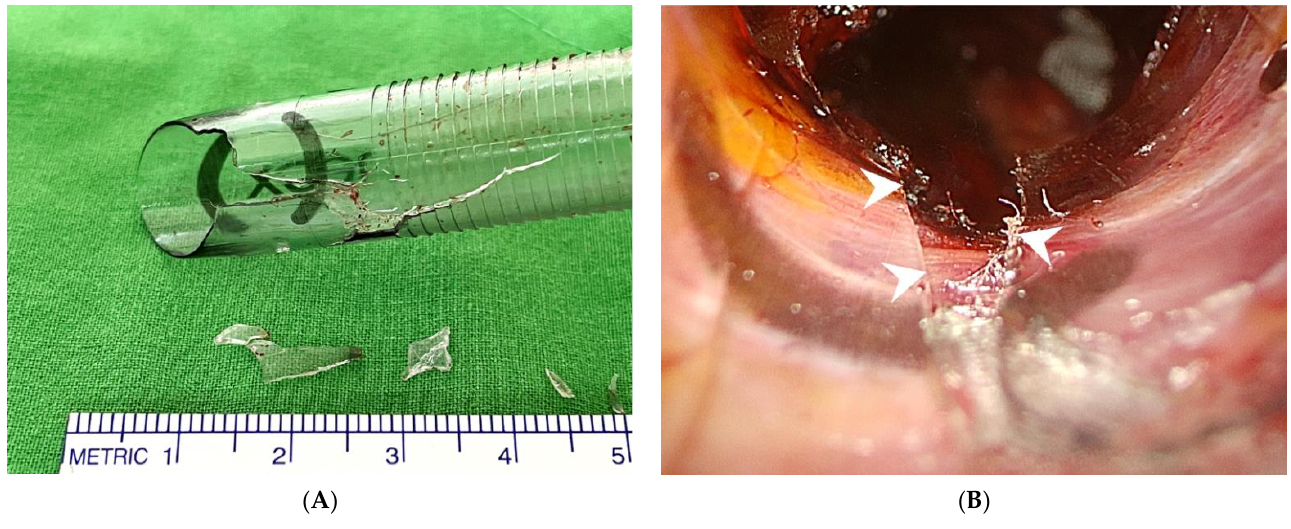
Figure 3. The broken cannula in Case 3. ( A ) The fractured part is at the distal end of cannula. Four fragments were retrieved. ( B ) Intraoperative view shows a cannula fracture with a defect on the ventral side of the cannula ( arrowheads ).